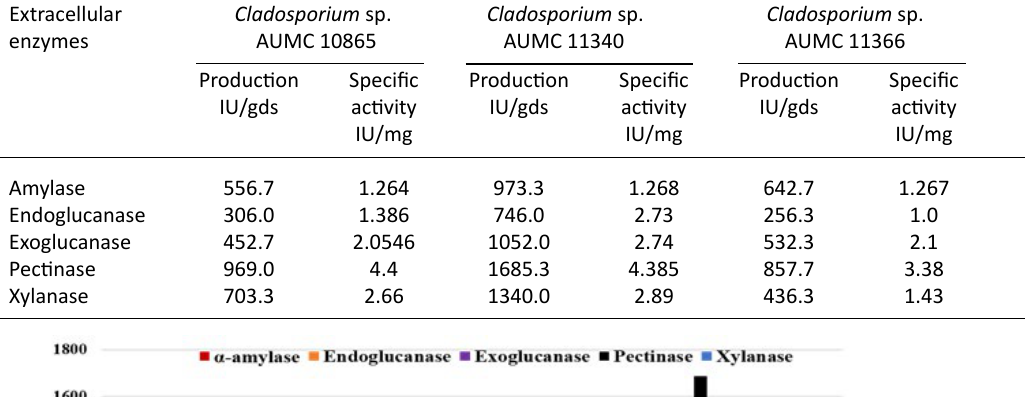
Table 4. Production and specific activity of amylase, endoglucanase, exoglucanase, pectinase and xylanase enzymes produced by Cladosporium isolates AUMC 10865, AUMC 11340 and AUMC 11366 from untreated orange peels in SSF at 30 °C Extracellular Cladosporium sp. Cladosporium sp. Cladosporium sp.